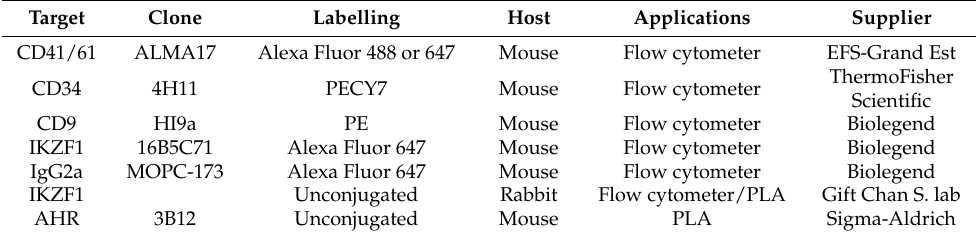
Table 1. Antibodies used in different